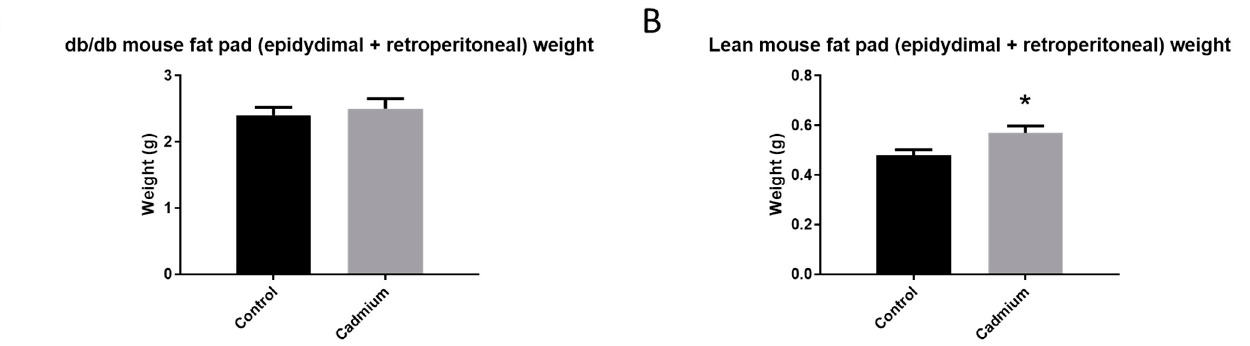
Figure 4. Changes in fat pad weights (epidydimal and retroperitoneal) after two weeks of 0.6 mg/kg/b.w./day of Cd dosing and two subsequent weeks of no Cd dosing for db/db mice ( A ), lean mice ( B ) and rats ( C ). Time point “0” is when last Cd dose was administered. Asterisk (*) indicates significant differences between Cd-treated and control animals. Two-way ANOVA with Tukey’s multiple comparison post-tests test; p ≤ 0.05 was considered significant; N = 4 per group for mice and N = 6 for rats per group; data are mean ± SE. 4. Discussion This study demonstrated that Cd dosed at 0.6 mg/kg/b.w./day (5 days per week, sub- cutaneous injection) for two weeks followed by two weeks of no additional Cd exposure in mice and rats, resulted in Cd levels in the renal cortex (Table 1) of similar levels found in the renal cortex of individuals residing in the United States following decades of low- level exposure [2]. This would indicate that this Cd dosing model represents the health effects resulting from long-term Cd accumulation at clinically relevant levels of exposure. Within the renal cortex, several changes in the levels of metals, other than Cd, were found. When all mouse and rat data were pooled together, zinc was higher in the Cd-treated